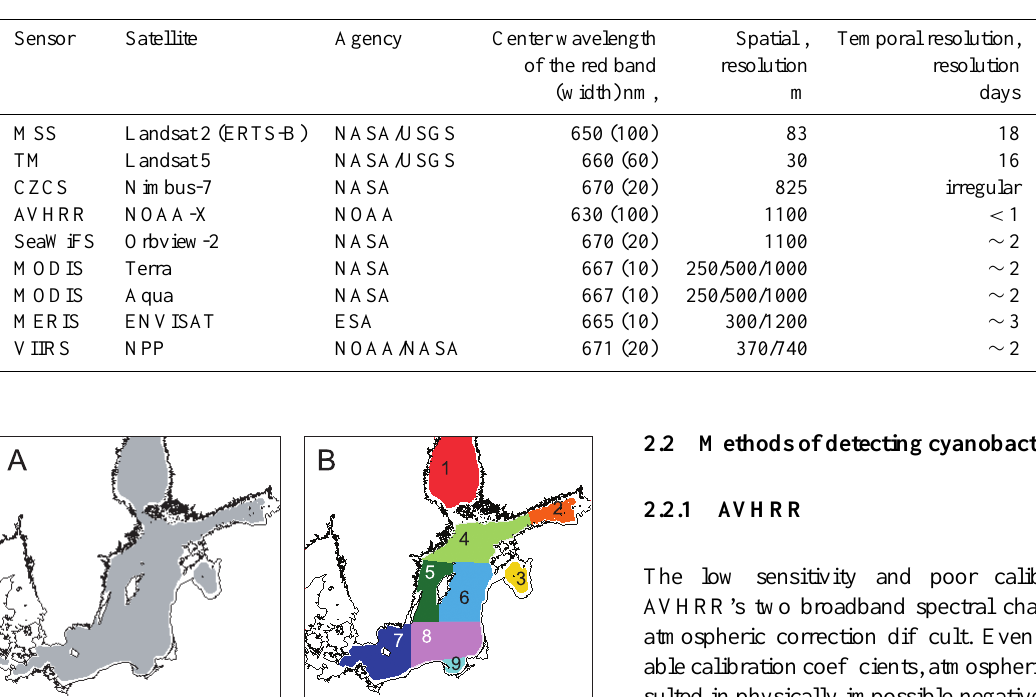
Table 1. Characteristics of satellite sensors used to detect cyanobacteria accumulations in the Baltic Sea.